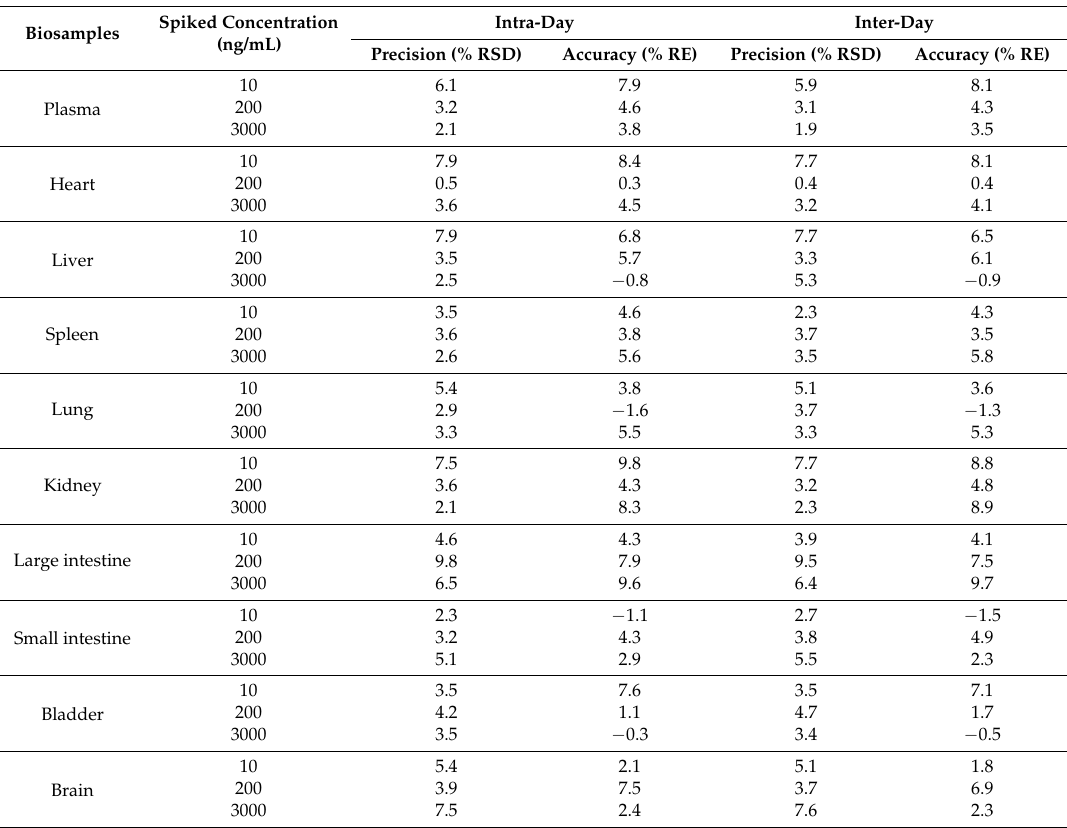
Table 2. Intra-and inter-day precision and accuracy obtained for DPTM analysis in plasma, tissue, homogenates, urine and feces ( n =